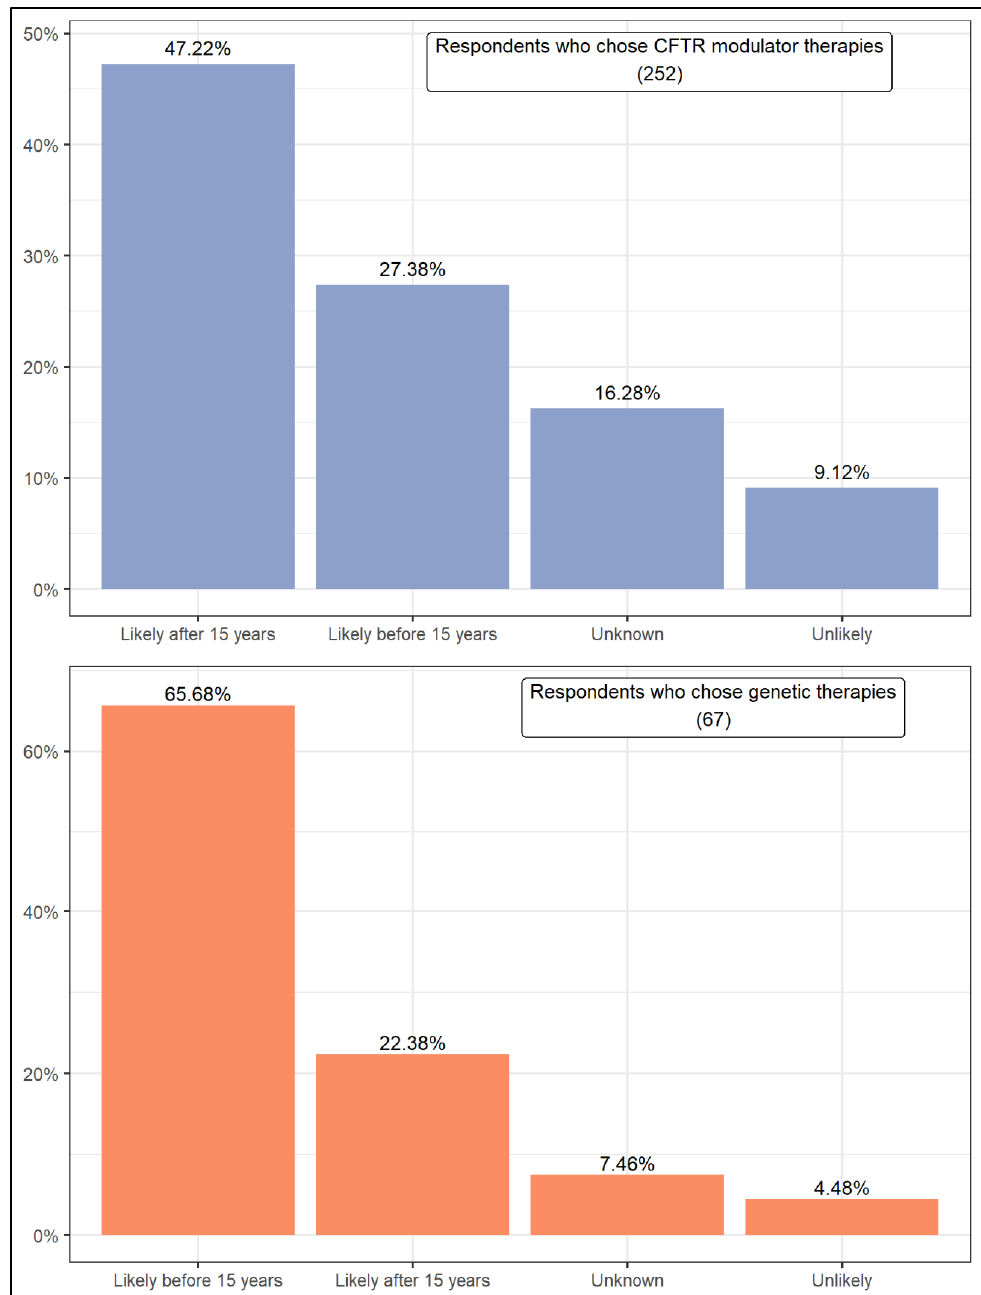
Figure 5. Expectation that fixing or replacing the CFTR gene will lead to a cure for